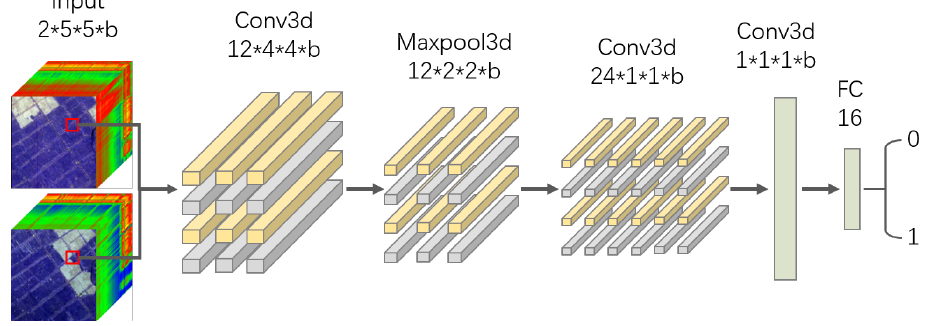
Figure 4. Architecture of the proposed